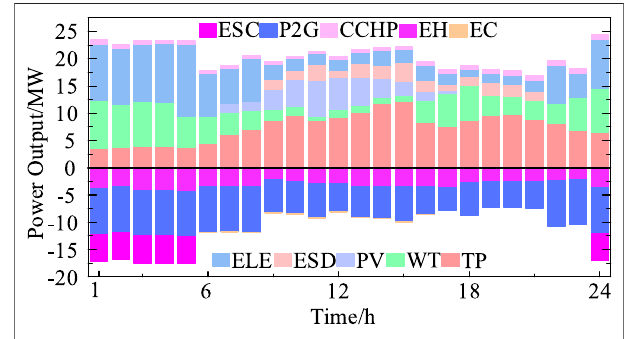
FIGURE 5 | Operation of each unit in case 1.